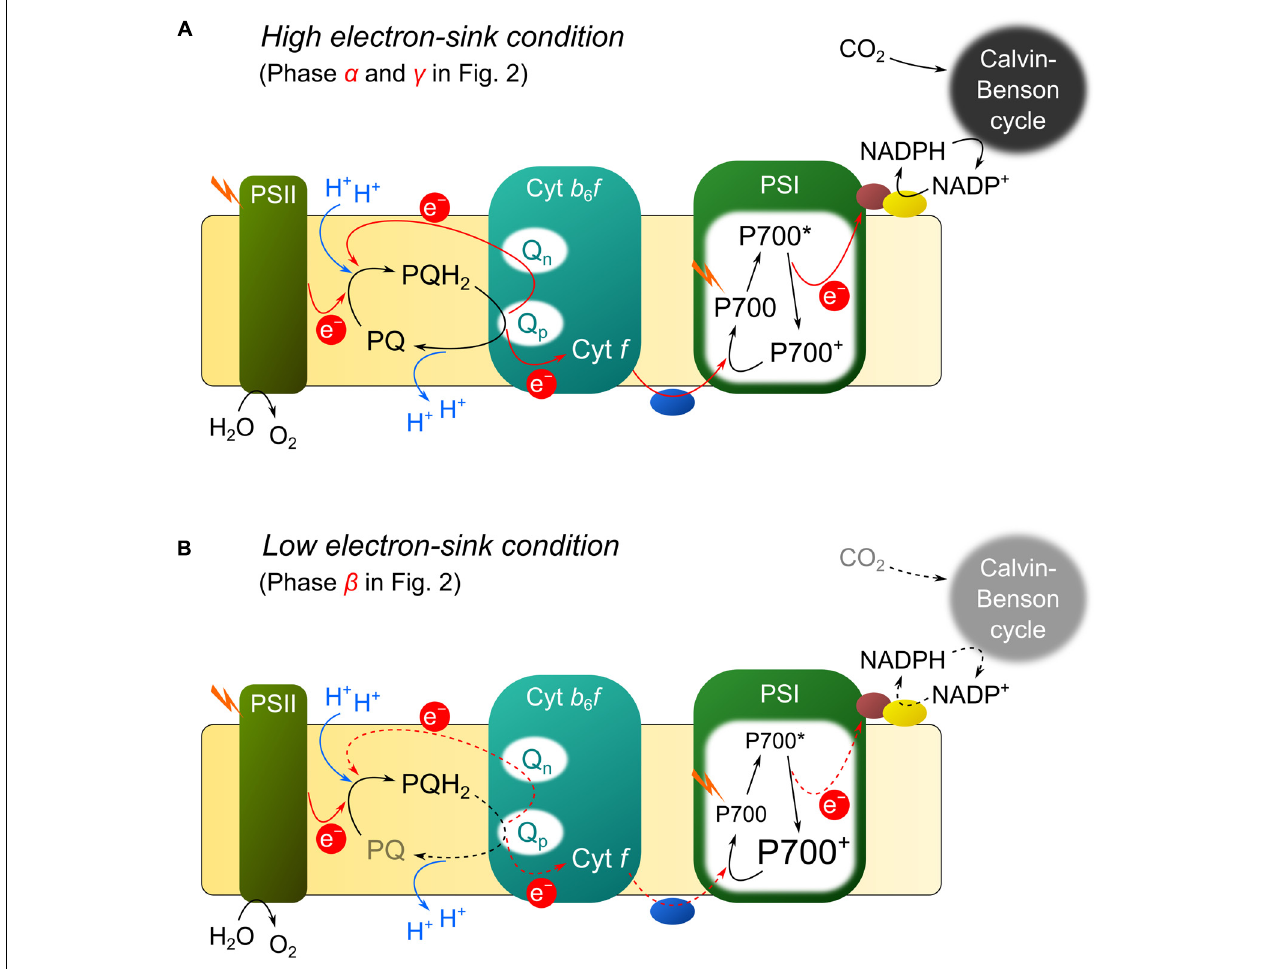
FIGURE 1 | Proposed model of reduction-induced suppression of electron flow (RISE). (A) Q-cycle in high electron-sink conditions (i.e., α and γ in Figure 2 ). The activity of photosynthetic linear electron flow (LEF) is high. Plastoquinone (PQ) is reduced to plastoquinol (PQH 2 ) with electrons from photosystem II (PSII) and the Q n site in the cytochrome b 6 / f complex (Cyt b 6 / f ). Then, PQH 2 is oxidized at the Q p site in Cyt b 6 / f . (B) The Q-cycle in low electron-sink conditions (i.e., β in Figure 2 ). The activity of LEF is low, and PQ pool is highly reduced, leading the suppression of the Q cycle in Cyt b 6 / f to oxidize P700 in photosystem I (PSI). Blue, brown, and yellow ellipsoid respectively indicate plastocyanin (or cytochrome c 6 ), ferredoxin, and ferredoxin-NADP + reductase. Red and blue lines indicate the transports of electrons and protons, and dashed red line shows the suppressed electron